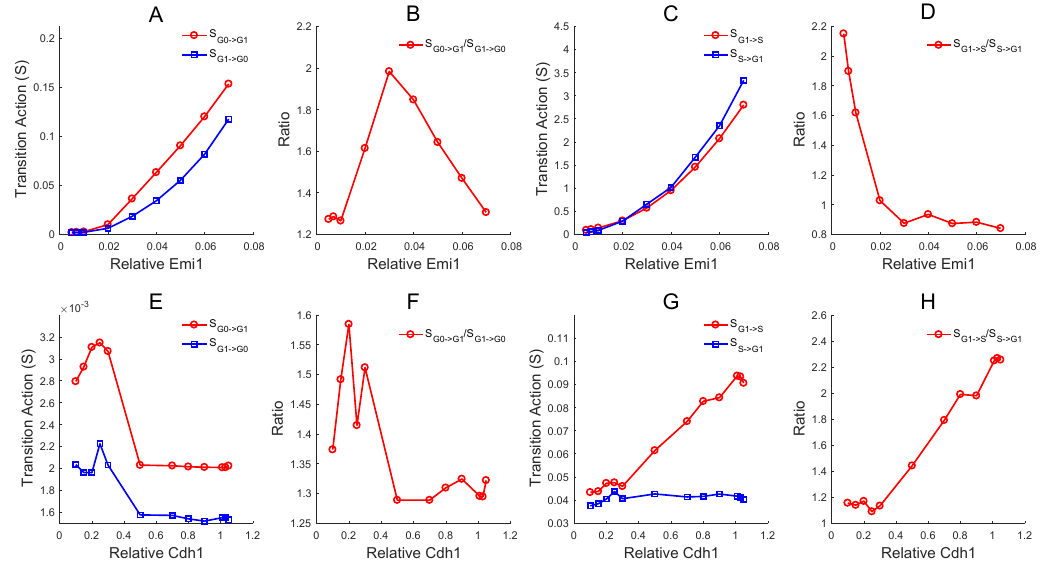
Figure 5. Effects of Emi1 ( A – D ) and Cdh1 ( E – H ) on the transition action (S) between G0 and G1 and between G1 and S. (A) The effect of Emi1 on the transition action between G0 and G1. The x axis represents the relative concentration of Emi1, and the y axis represents the value of the transition action (S). The red line represents the action from G0 to G1 and the blue line represents the action from G1 to G0. ( B ) The ratio of the action between G0- > G1 and G1- > G0 changes with Emi1. ( C ) The effect of Emi1 on the transition action (S) between G1 and S. ( D ) The ratio of the action between G1- > S and S- > G1 changes with Emi1. (E) The effect of Cdh1 on the transition action (S) between G0 and G1. ( F ) The ratio of the action between G0- > G1 and G1- > G0 changes with Cdh1. ( G ) The effect of Cdh1 on the transition action (S) between G1 and S. ( H ) The ratio of the action between G1- > S and S- > G1 changes with